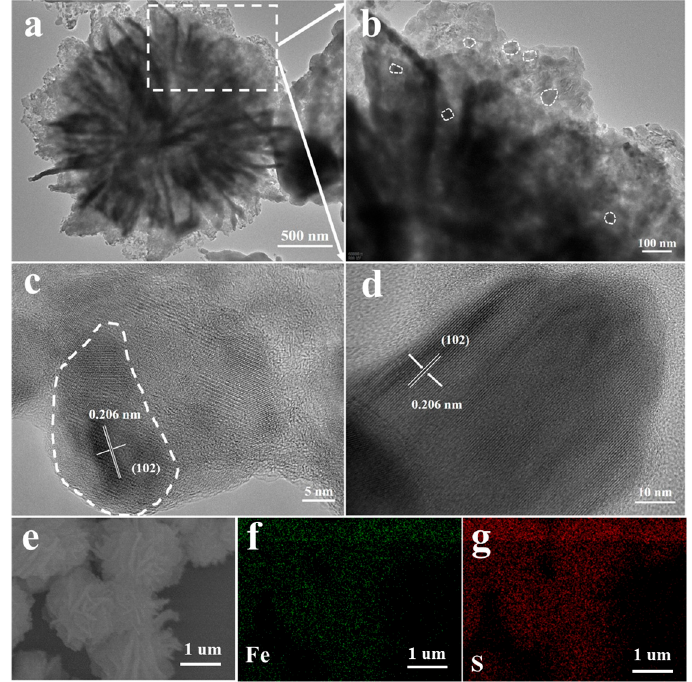
Figure 3. ( a , b ) TEM images of the as-prepared 3D F-FeS; ( c , d ) HRTEM images of the 3D F-FeS and B-FeS; ( e – g ) EDS elemental mapping showing the homogenous distribution of Fe and S elements in 3D F-FeS nanostructure.